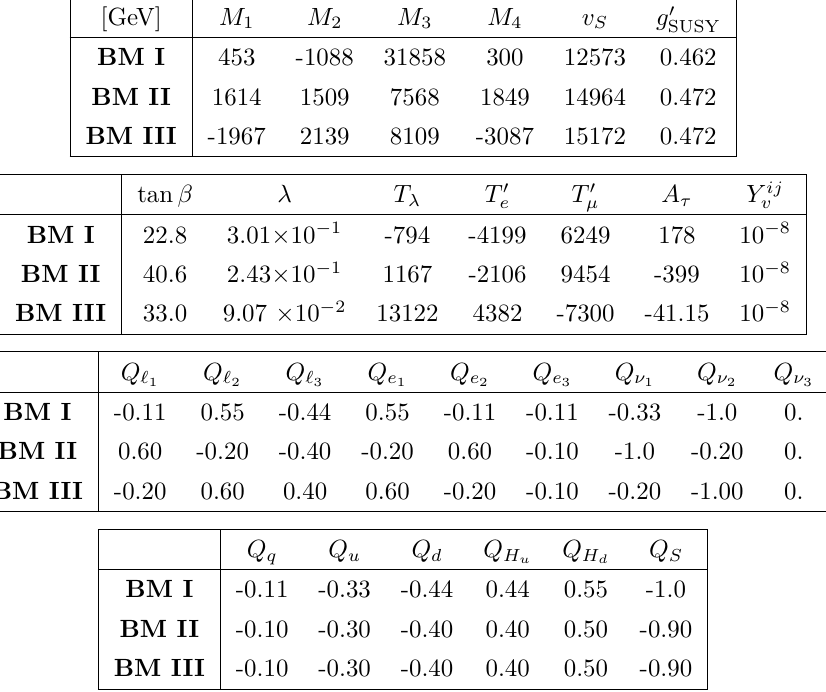
Table 5 . Set values for the free Non-UMSSM parameters defining our benchmark scenarios BM I , BM II and BM III . All masses are given in